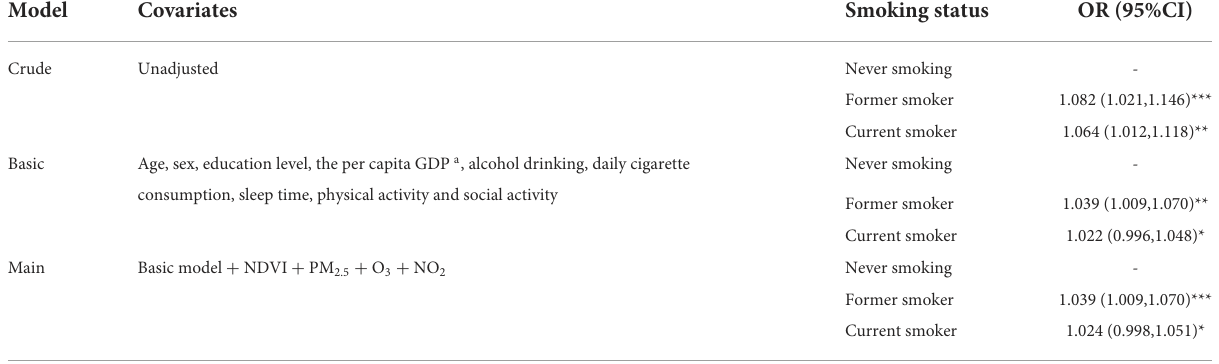
TABLE 3 Odds ratios (OR) of hypertension (with 95% confidence intervals, 95%CI) associated with smoking.